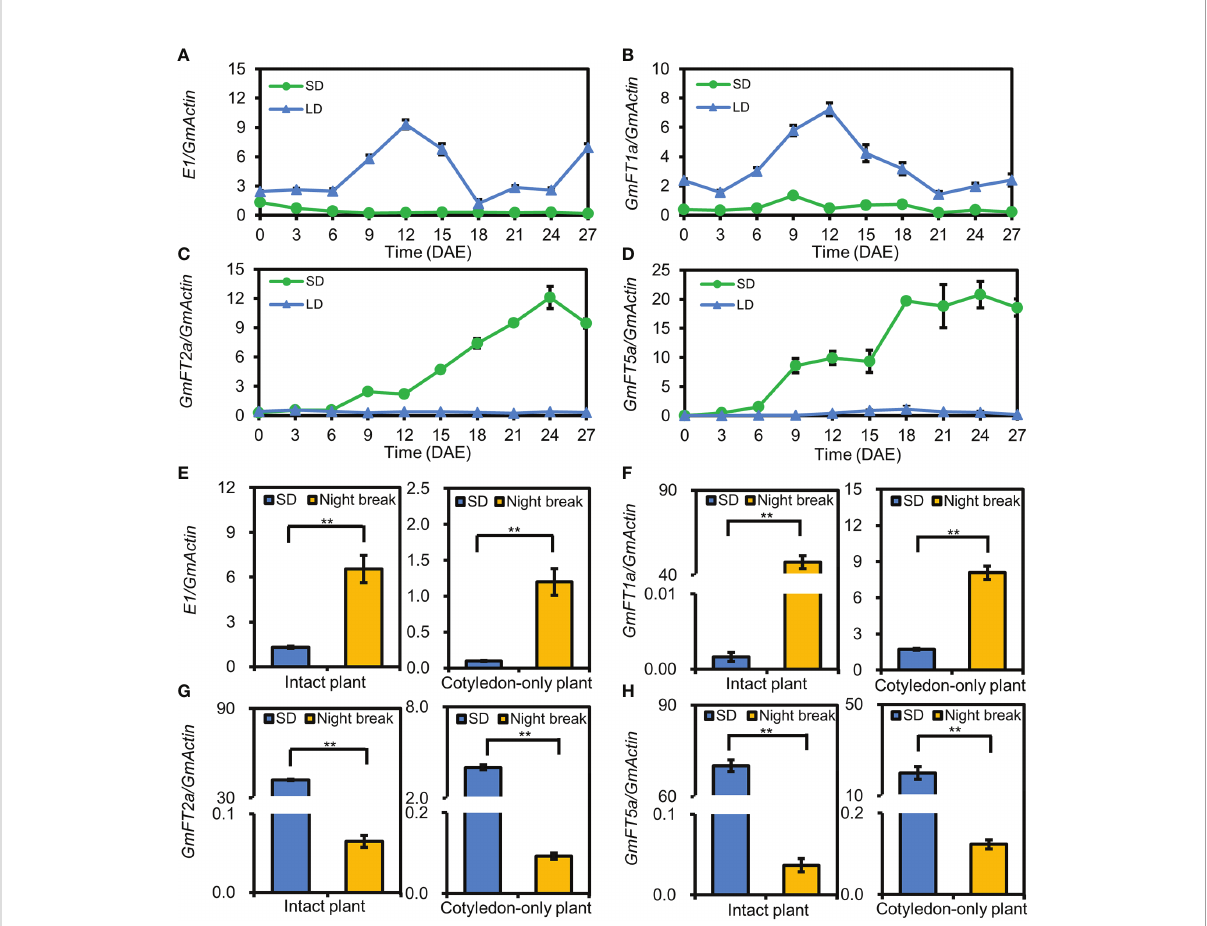
FIGURE 4 The expression pattern of fl owering-time genes in cotyledon-only plants. (A – D) The expression pattern of E1 (A) , GmFT1a (B) , GmFT2a (C) , and GmFT5a (D) in the cotyledons of Zigongdongdou cotyledon-only plants (COPs) under short-day (SD, 12 h light/12 h dark) and long-day (LD, 16 h light/8 h dark) conditions. The samples were harvested at 4 h after light on every three days from the emergence. Values represent the mean ± standard deviation from three biologically independent cotyledon samples from different plants. (E – H) The expression pattern of E1 (E) , GmFT1a (F) , GmFT2a (G) , and GmFT5a (H) in the unifoliolate leaves of intact plants and cotyledons of COPs in SD and night-break. The samples were harvested at 4 h after light on. Values represent the mean ± standard deviation from three biologically independent unifoliolate or cotyledon samples from different plants. The reference gene is GmActin . Double asterisks indicate an extremely signi fi cant or signi fi cant difference ( t -test, p value <